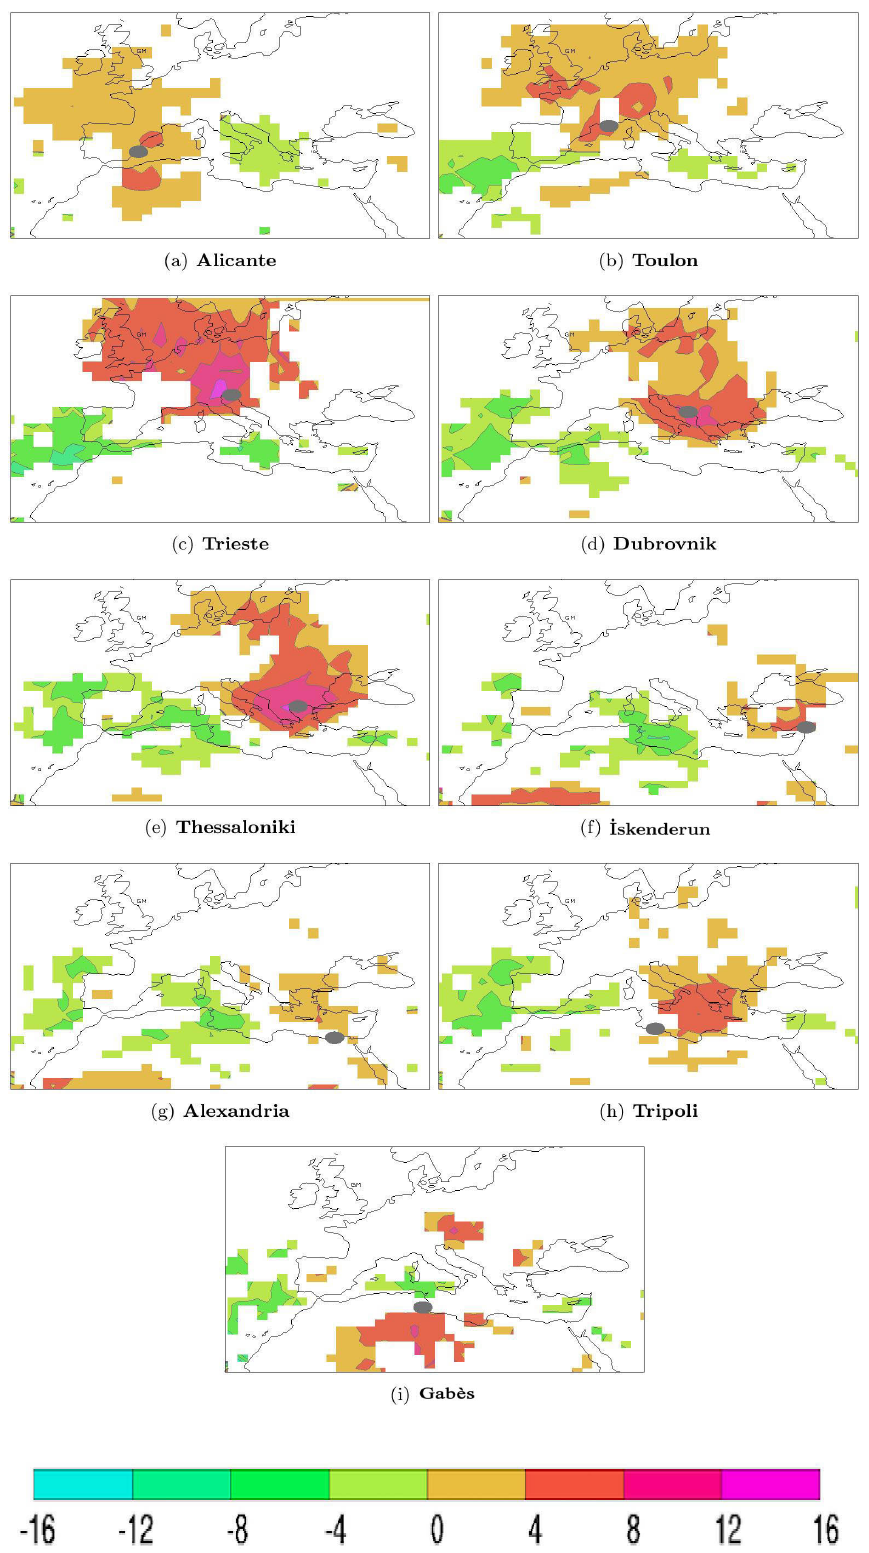
Figure 9. Mean SLA (cm) at the coastal station as a function of cyclone positions. Each panel considers a different coastal station: Ali- cante (a) , Toulon (b) , Trieste (c) , Dubrovnik (d) , Thessaloniki (e) , ˙ Iskenderun (f) , Alexandria (g) , Tripoli (h) , Gabès (i) . Only values reaching the 90% significance level are